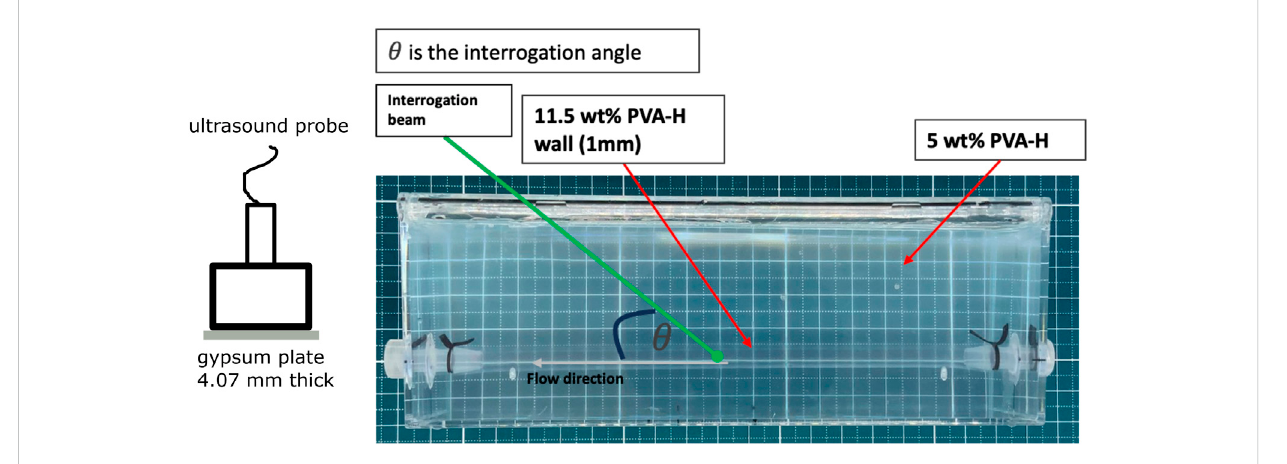
FIGURE 8 PIV measurement results compared to theoretical values.